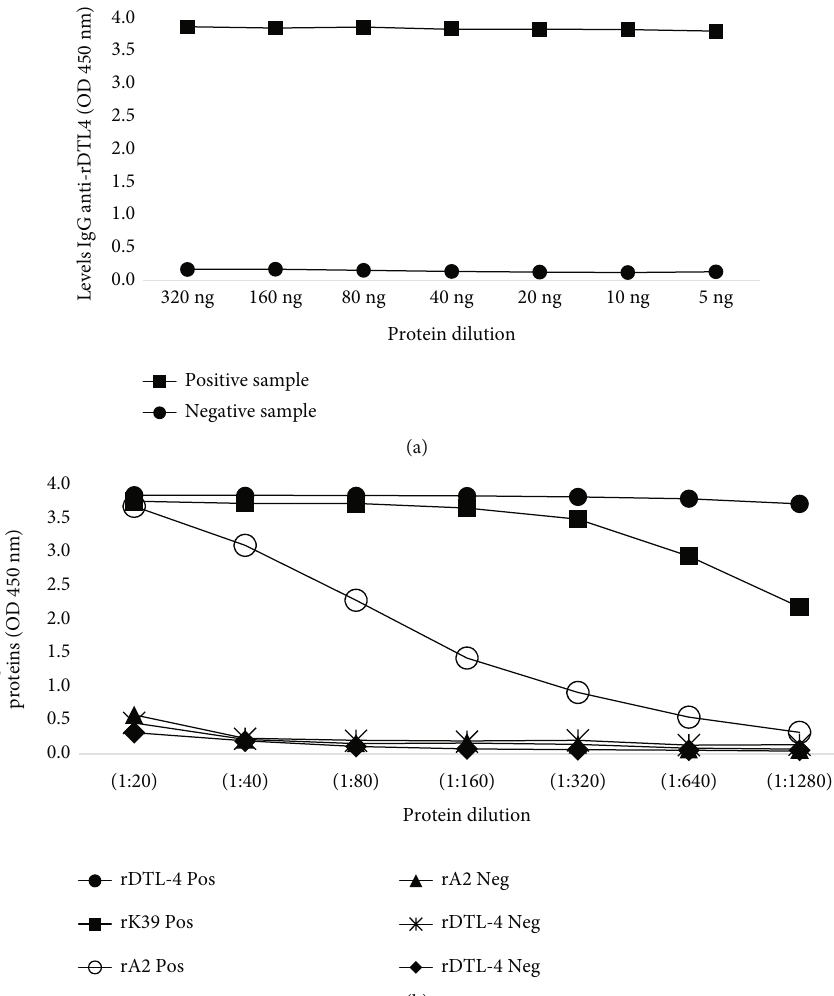
Figure 5: Titration curves for the determination of protein concentration and sera dilutions for DTL-4-ELISA. Pools of ten VL-positive and ten negative sera were assayed. (a) Titration of DTL-4 concentration by adding successive decreasing amounts of protein to wells on ELISA plates. (b) Titration of anti-DTL-4, anti-A2, and anti-K39 antibodies in pools of sera, using 10ng of each protein per well.